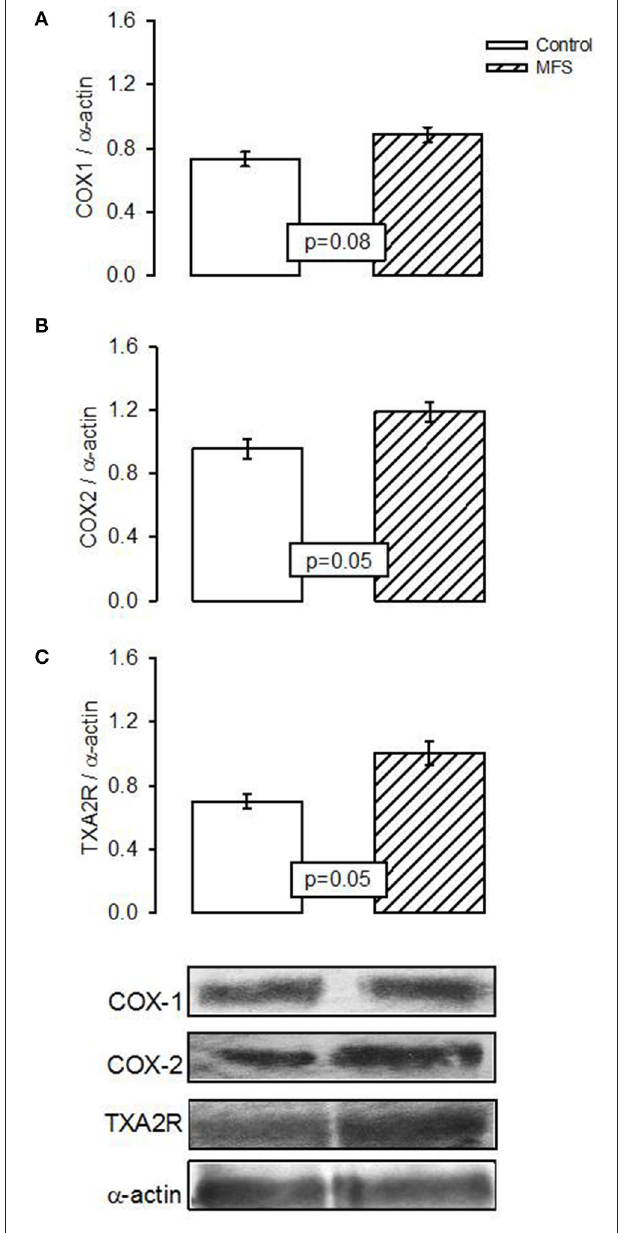
blots of (A) COX1, (B) COX2, and (C) Txs protein expressions in aortic homogenate of control subjects ( n = 6) and MFS patients ( n = 14). Data are means ±